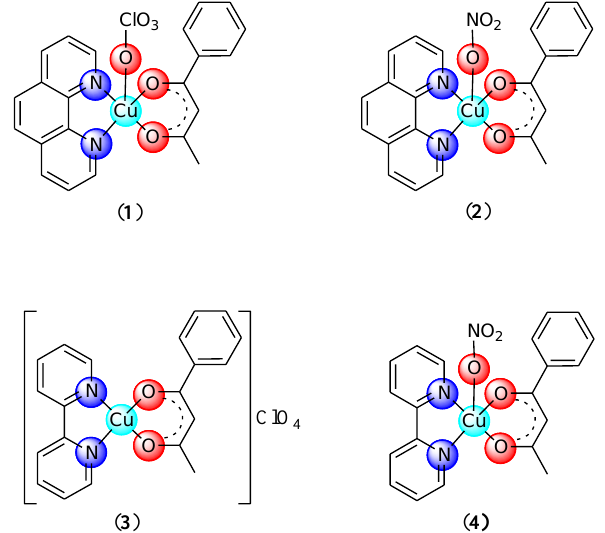
Figure 1. The structure of complexes.